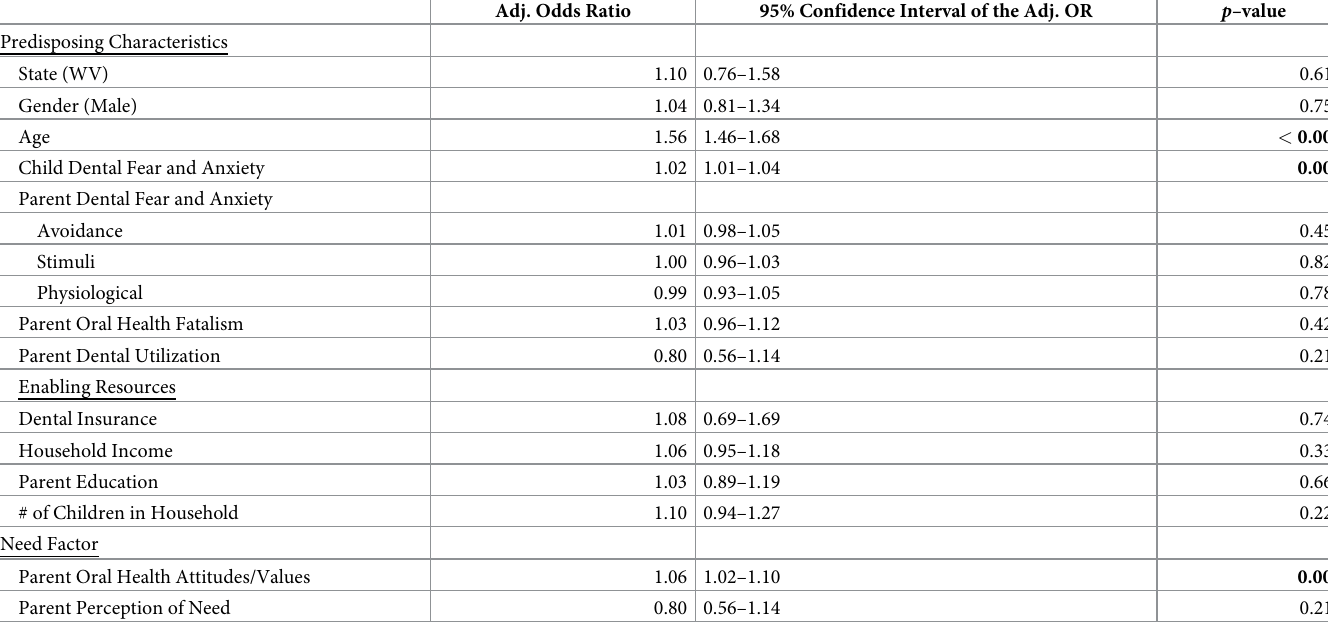
Table 2. Combined (WV and PA) generalized estimating equation model results of dental utilization with using Andersen model factors (n = 1178); pooled imputed results reported. Adj. Odds Ratio 95% Confidence Interval of the Adj. OR